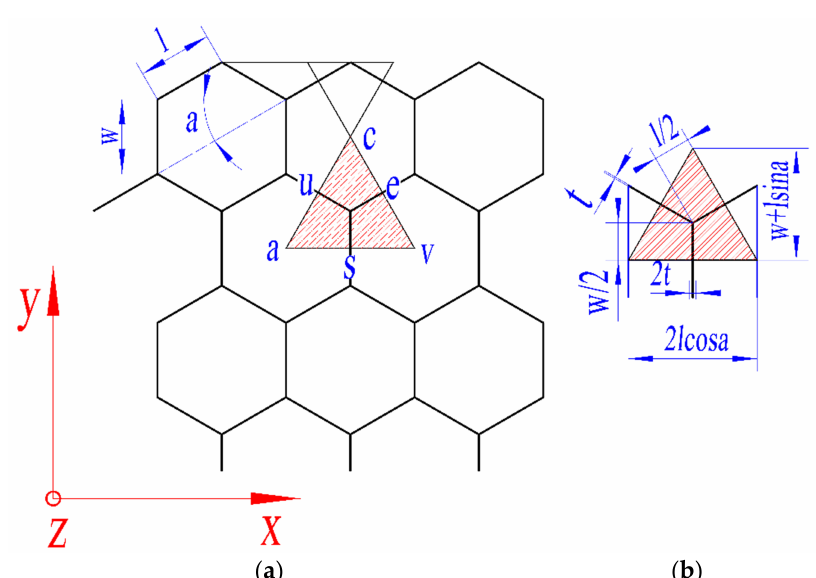
Figure 3. Hexagonal honeycomb structure: ( a ) cross section of hexagonal honeycomb and ( b ) cross section Y-cell.